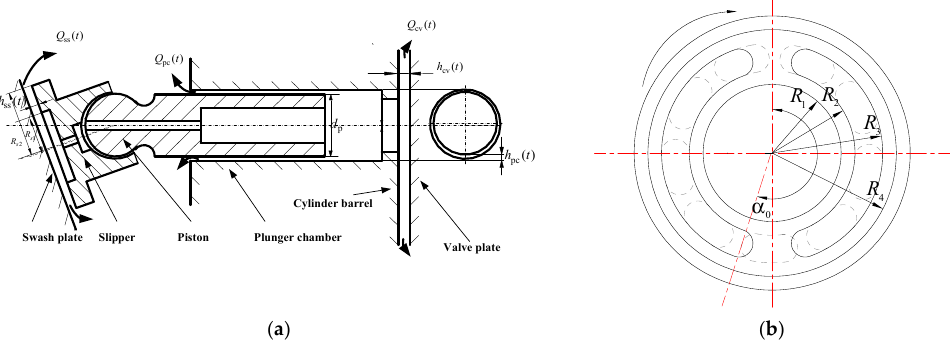
Figure 5. Schematic structure of three main friction pairs: ( a ) three main friction pairs; ( b ) valve plate.